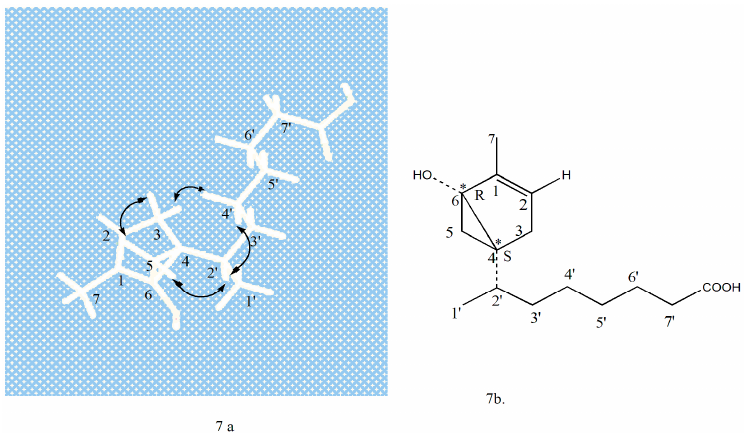
Figure 7. The absolute configuration of compound 3 . ( a ) NOESY correlations of compound 3 ; ( b ) The absolute configuration of compound 3 (The asterisk represents the chiral carbon atom).